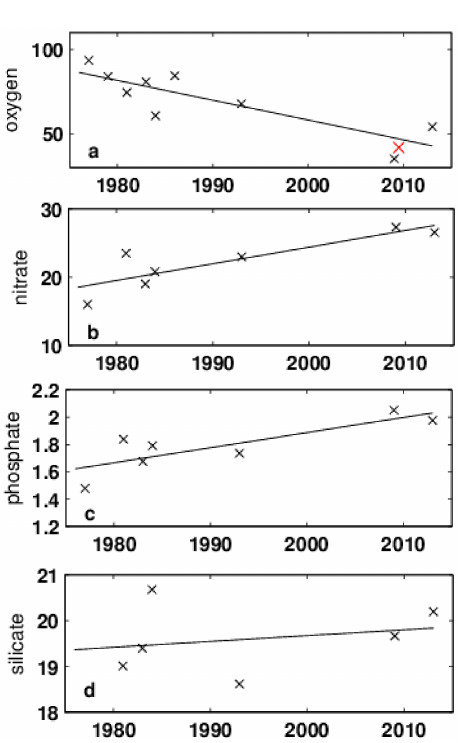
Figure 13. Trends since 1976 for the layer 50 to 300m depth between 2 and 5 ◦ S and 84 and 87 ◦ W in µmolkg − 1 yr − 1 for (a) oxygen, (b) nitrate, (c) phosphate, and (d) silicate. For sili- cate the year 1976 was removed due to an unrealistic mean value (14.9µmolkg − 1 yr − 1 ). The red cross in (a) is the mean oxygen value for 2009 from profiling floats with oxygen sensors which pro- vided profiles in the investigation